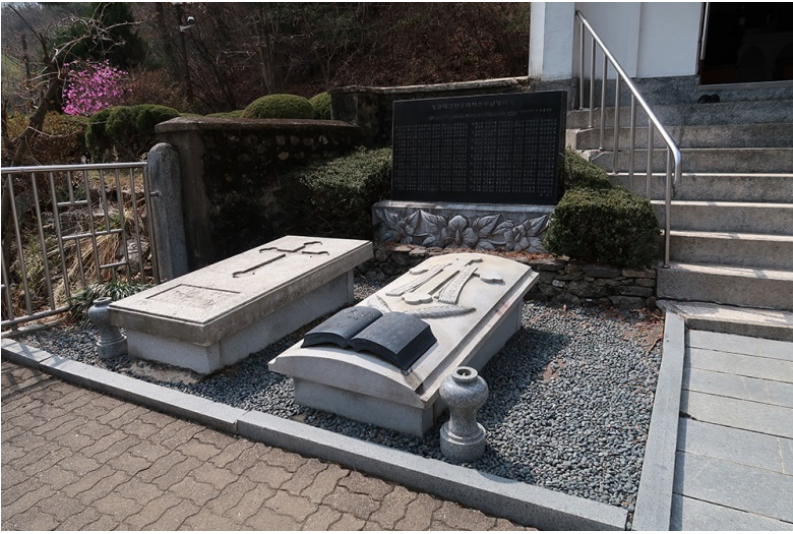
Figure 16. Graves of Father Kang Do-Young and Father Kim Dae-Geon; image dated April 2021 [source: photo by author].